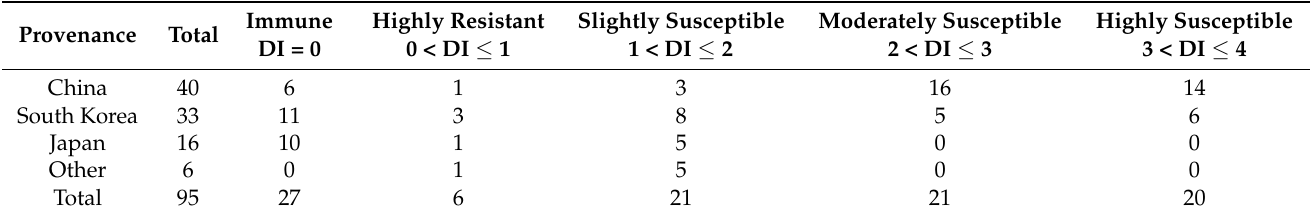
Table 1. Summary of resistance to P. brassicae race 4 in radish lines of different